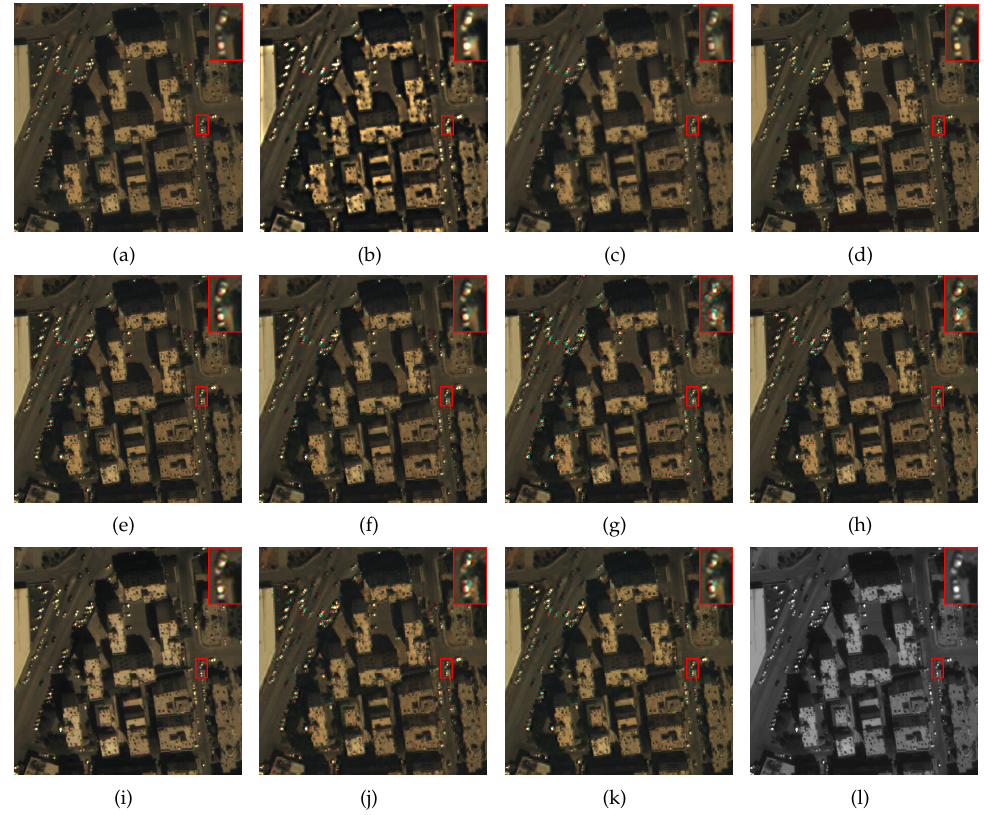
Figure 11. Qualitative comparison of MPFINet with ten counterparts on a typical satellite image pair from the WV3 dataset at full resolution. The enlarged view of the corresponding region is shown in the red box ( a ) Brovey. ( b ) MTF_GLP_HPM. ( c ) SFIM. ( d ) CNMF. ( e ) PNN. ( f ) PANNET. ( g ) SRPPNN. ( h ) MUCNN. ( i ) ZeRGAN. ( j ) PanFormer. ( k ) MPFINet (ours). ( l )